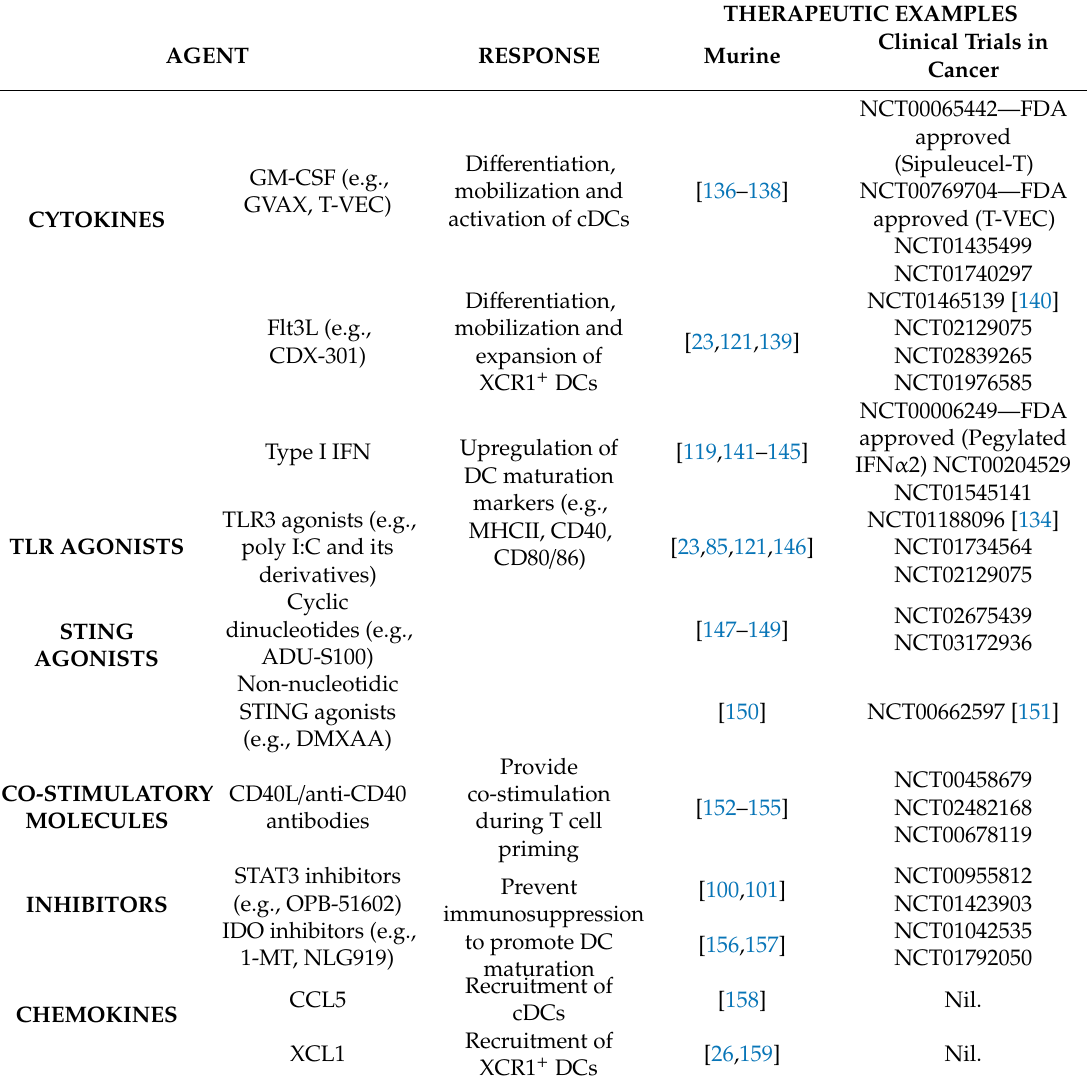
Table 2. Agents promoting cross-presenting DC development, maturation, function, and / or